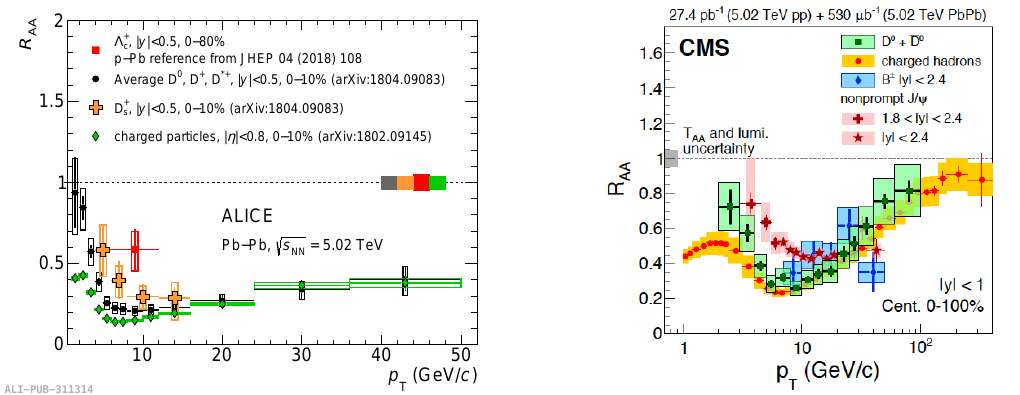
Figure 2. Left: R AA of prompt Λ + c (red marker) compared with the non-strange D mesons (black markers), D + s (orange markers), and charged particle (green markers). Right: D 0 meson R AA as a function of p T (green markers) compared to the R AA of charged particles (red circles), B + mesons (blue markers), non-prompt J/ Ψ meson (purple markers) and charged particles (red